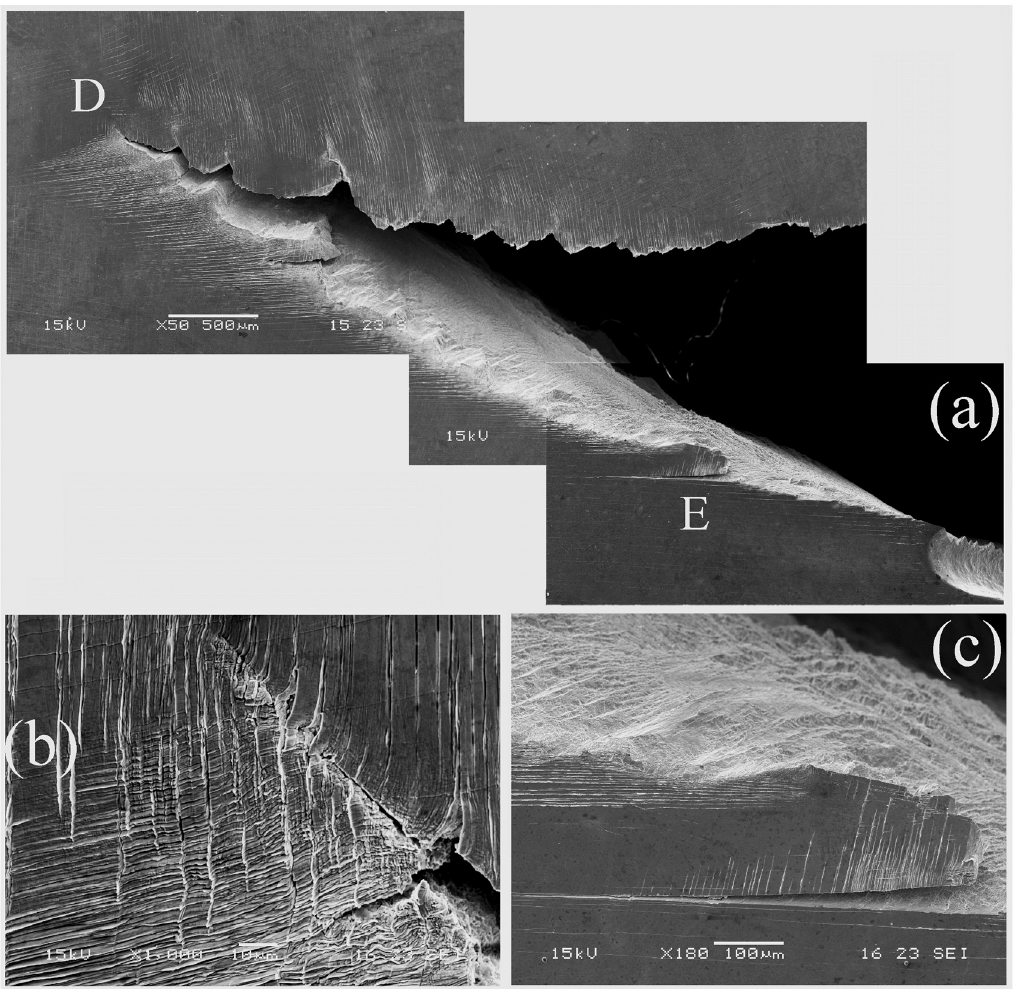
Figure 6. SEM images of the free surface of specimen 2 with a crack nearly parallel to the (110) plane. ( a ) general view, ( b ) the tip of the crack, D, and ( c ) area E. The slip steps generate extrusions and intrusions, which have attracted much interest in